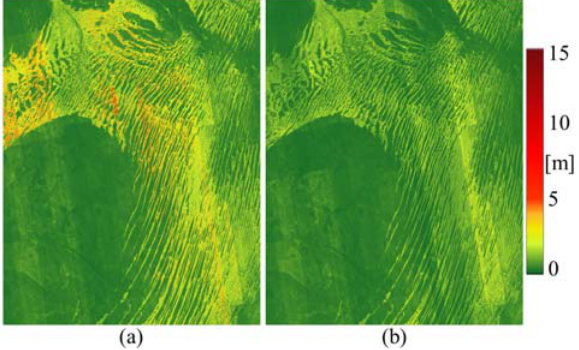
Figure 4. Quicklook mosaics of height error standard deviation per pixel over the Sahara desert, generated by combining first year and second year coverages only (a) and adding desert acquisitions